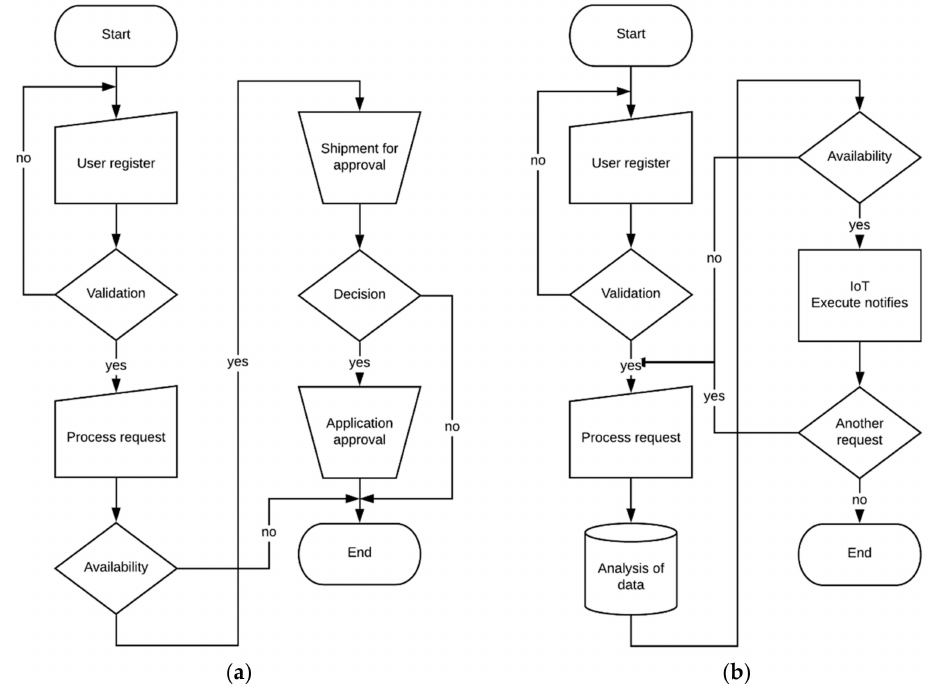
Figure 4. Block diagram of a model for the process request: ( a ) traditional model for the process request; ( b ) model for requesting processes through the use of